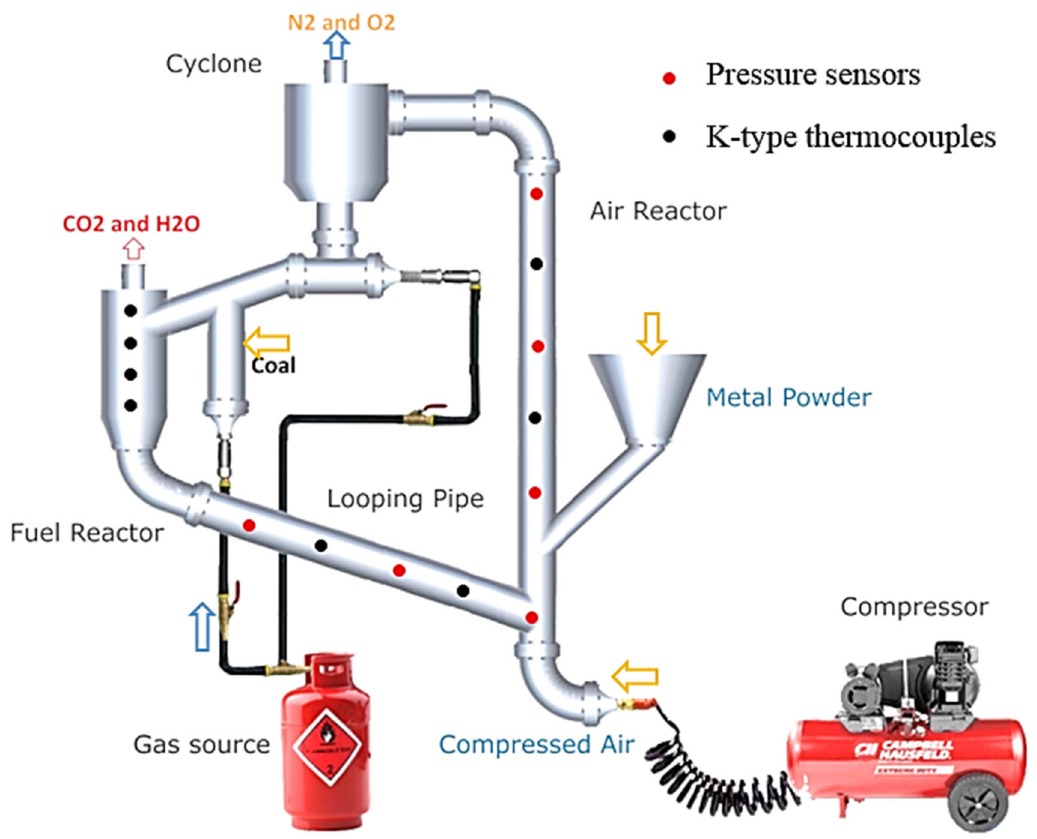
Fig. 1 Schematic diagram of chemical looping combustion